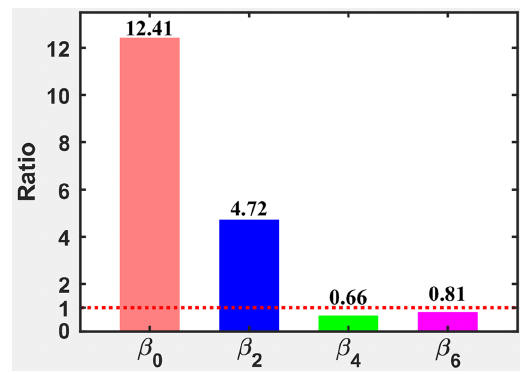
FIG. 20. β parameter analysis of measured Δ PDF. Ratio of integrated β parameter values for positive and negative time delays are plotted in the figure with β order of 0, 2, 4, and 6. Each β parameter is obtained by integration between 3.2 Å and 4.0 Å. A red dotted line indicates a ratio of